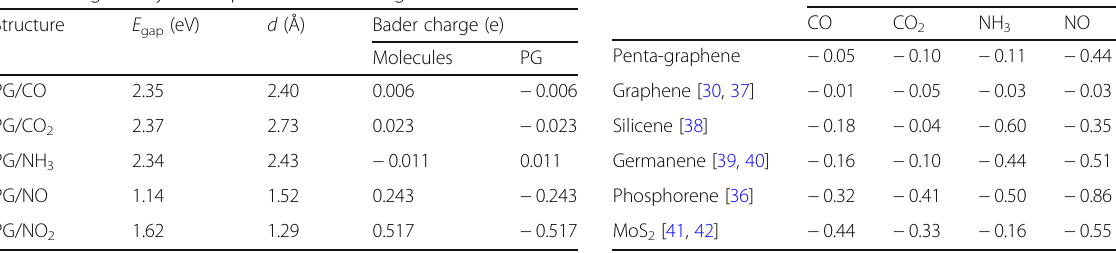
Table 2 Comparative summary of adsorption of molecules (adsorption energies in eV) on different 2D surfaces collected from literature vs on the penta-graphene surface